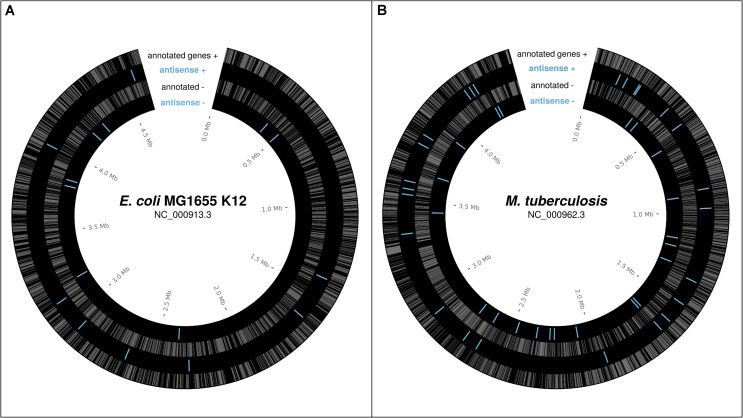
Reported potential protein-coding ORFs overlapping in antisense, based on ribosome profiling experiments. (A) Reported antisense OLGs in E. coli K12 (NC_000913.3) – Weaver et al. (2019), Friedman et al. (2017; sRNAs with evidence of translation). (B) Reported antisense OLGs in M. tuberculosis (NC_000962.3) –Smith et al. (2019). Annotated genes gray. Antisense blue.